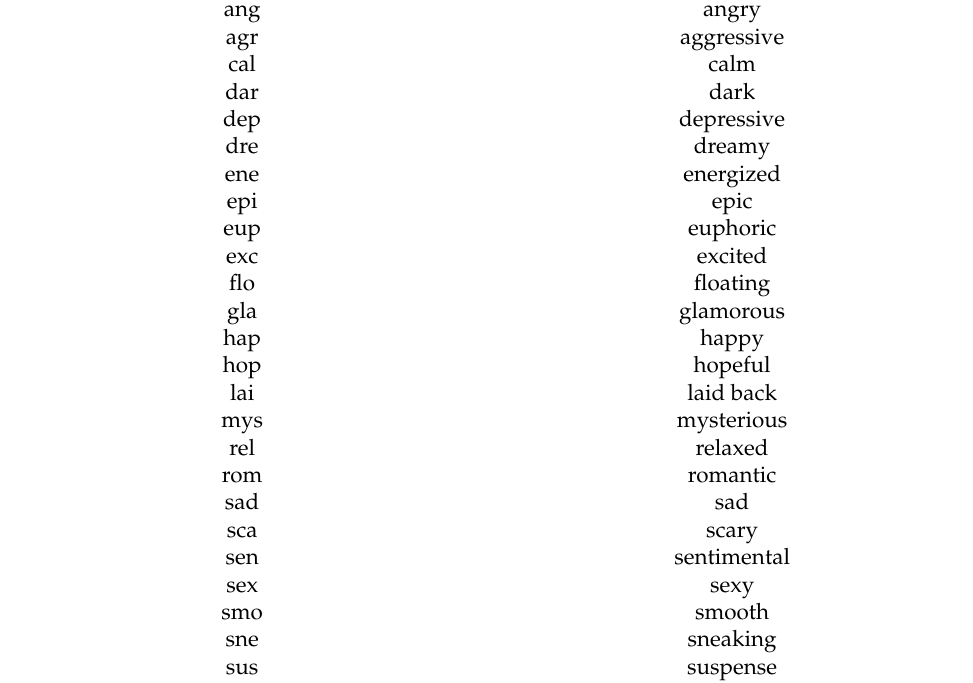
Table 5. Short names for labels used in Table